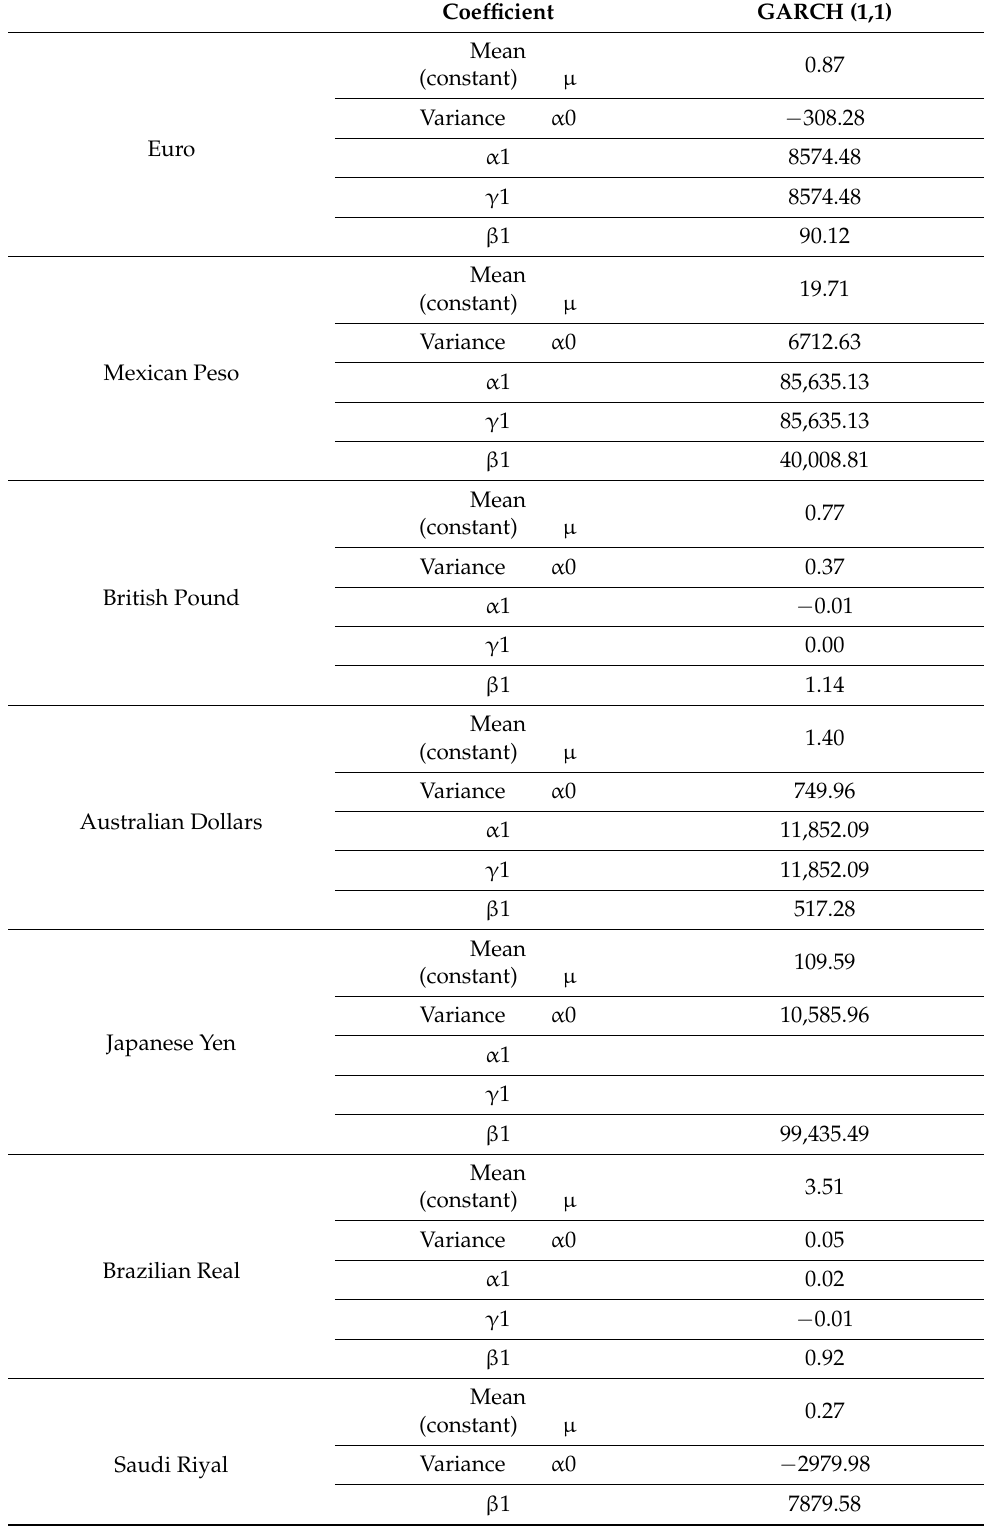
Table 4. Estimated Result of GARCH (1,1)